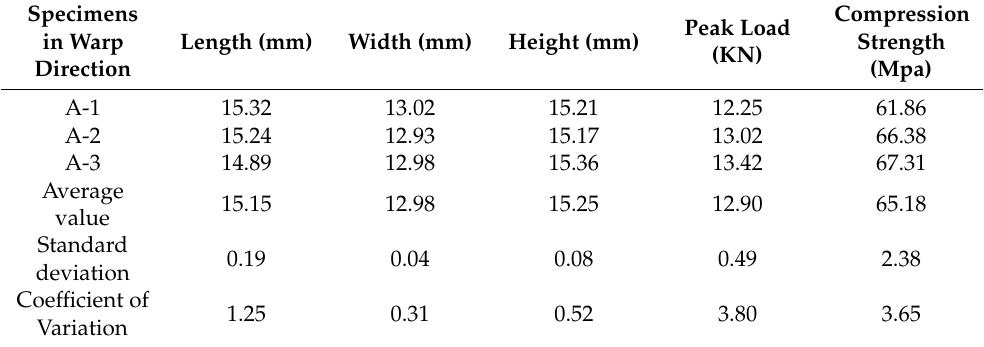
Table 2. Quasi-static compression test data for warp specimens.